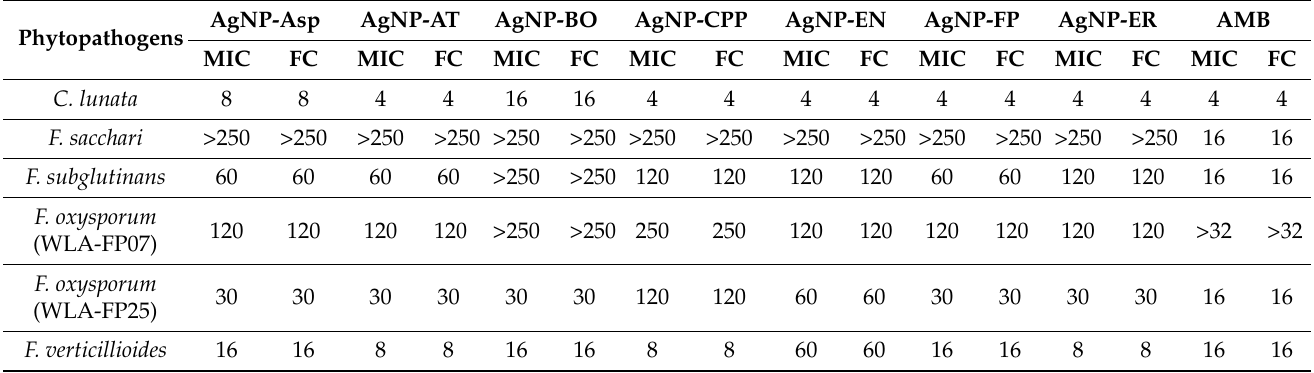
Table 4. Antifungal activity of the AgNP-Asp, AgNP-AT, AgNP-BO, AgNP-CPP, AgNP-EN, AgNP- ER, and AgNP-FP by minimal inhibitory concentration (MIC— µ M) on the phytopathogens C. lunata